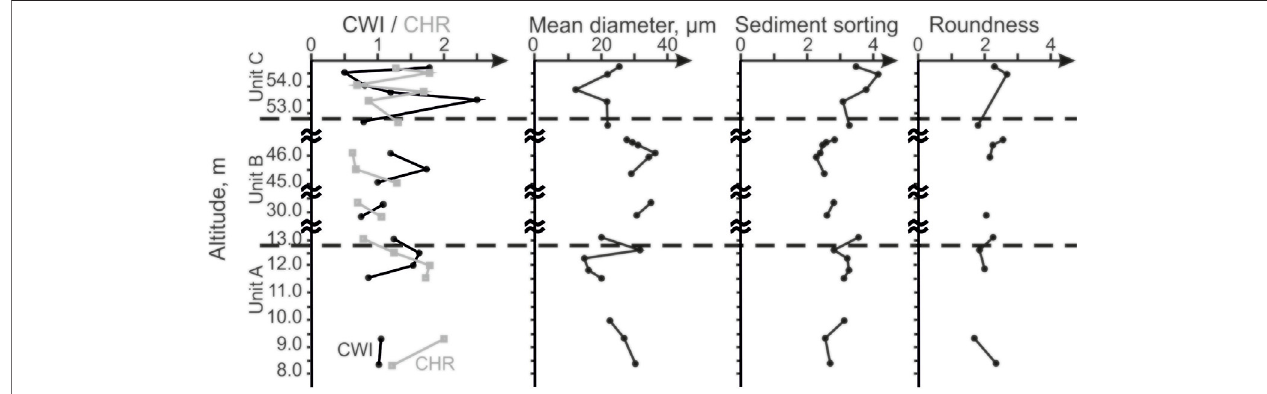
FIGURE 8 | Sediment parameters analysis on the Duvanny Yar sediments: CHR (cid:1) coef fi cient of heavy residue; CWI (cid:1) cryogenic weathering index. Unit A and Unit B – late Pleistocene Yedoma, Unit C – Holocene Cover Layer.